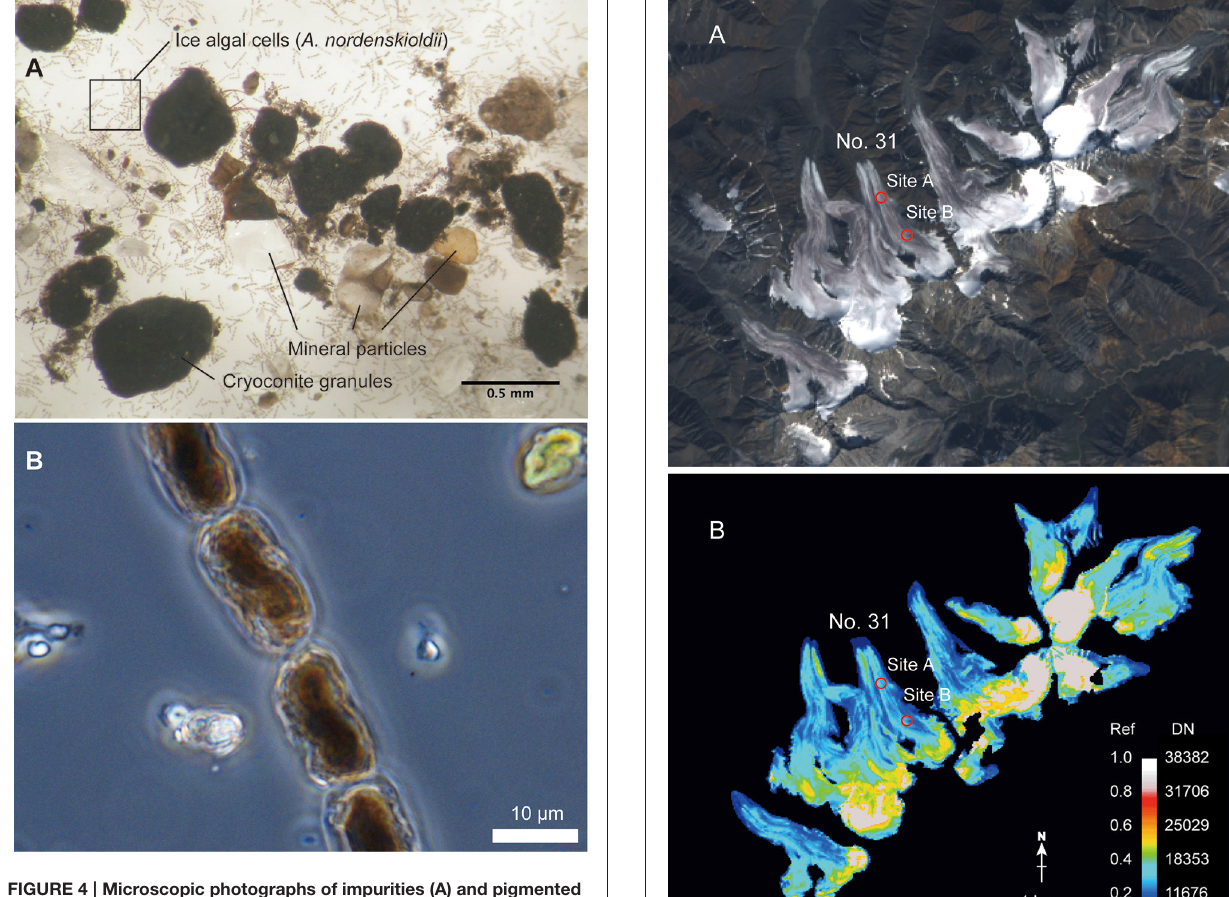
FIGURE 4 | Microscopic photographs of impurities (A) and pigmented ice algae, Ancylonema nordenskioldii (B), collected at site B on Glacier No. 31. Inner structure of the cells is damaged due to preservation in frozen state. (mean 118 µ L m − 2 , Table 1 ). A. nordenskioldii accounted for